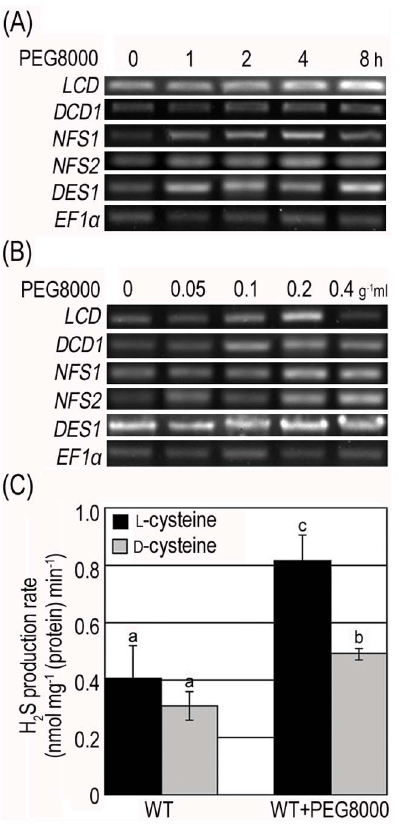
Figure 1. Effects of PEG8000 on the expression of genes controlling H 2 S generation and on H 2 S production rate in WT seedlings. ( A ) Expression detection of H 2 S generating critical enzymes coding genes in WT seedlings treated with 0.1 g ml 2 1 PEG8000 for 0, 1, 2, 4, 8 h; ( B ) Expression detection of H 2 S generating critical enzymes coding genes in WT seedlings treated 2 h with 0, 0.05, 0.1, 0.2, 0.4 g ml 2 1 PEG8000. EF1- a was used as an internal control of RT-PCR; ( C ) Endogenous H